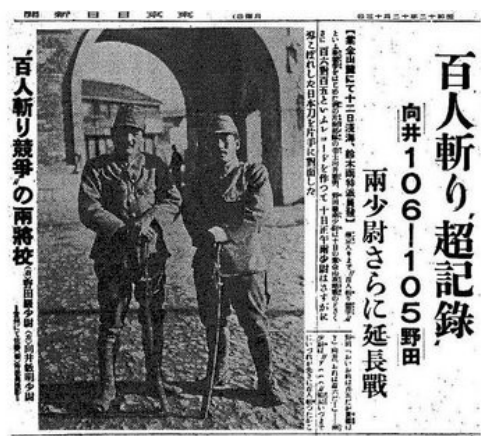
Figure 12. Japanese soldiers' killing contest. Source: The Japan Advertiser.